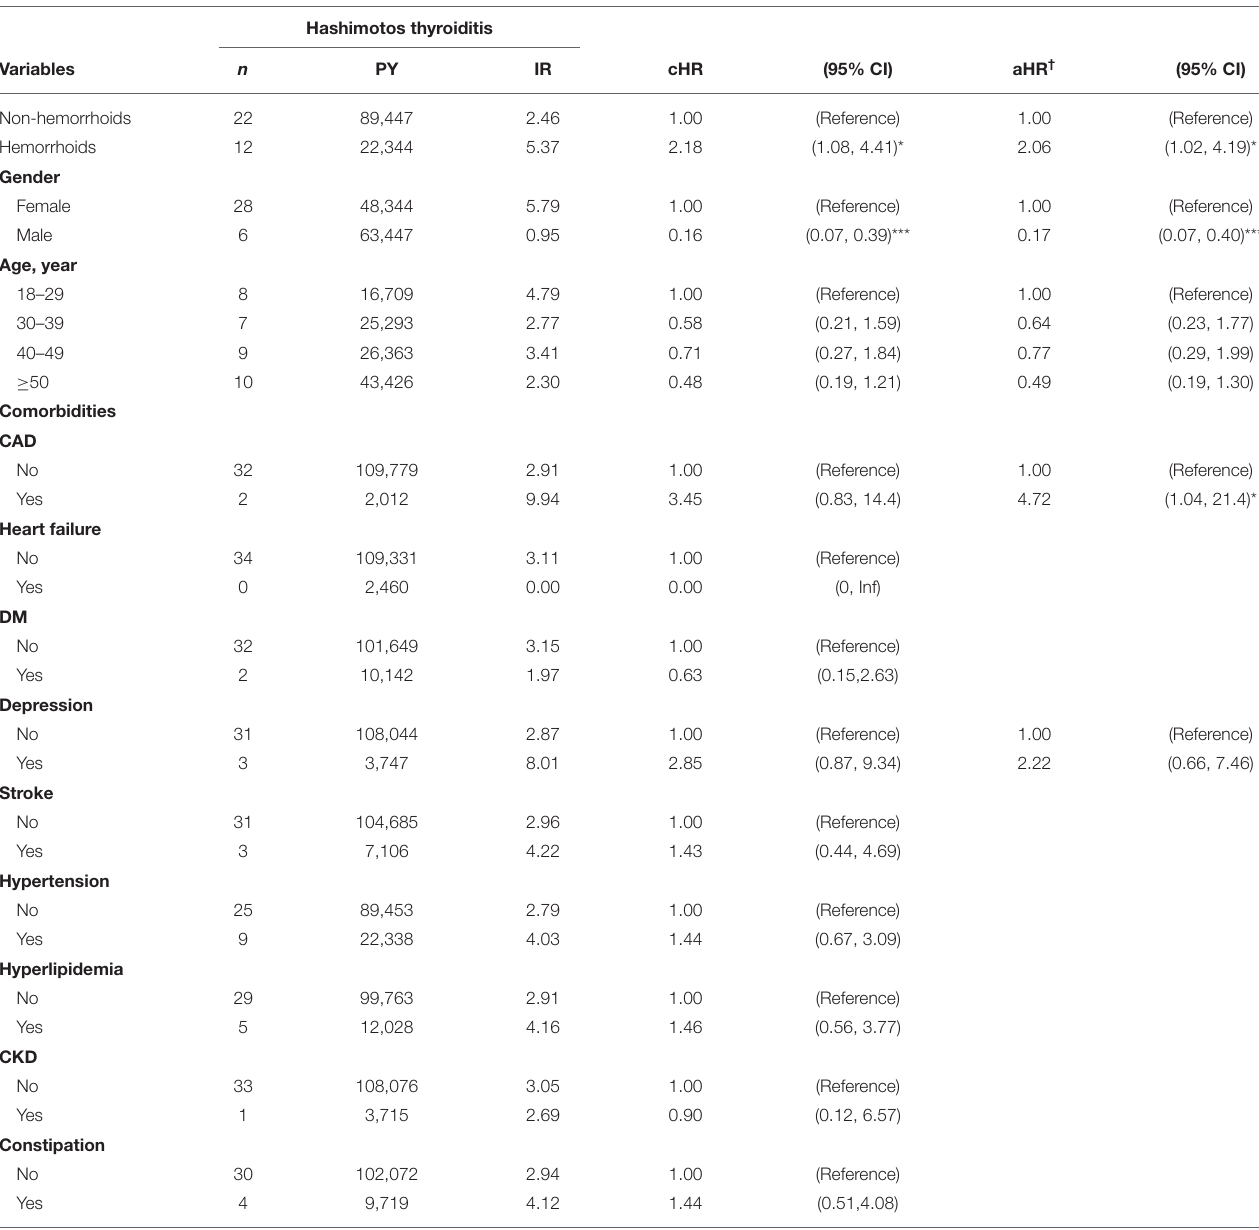
TABLE 2 | Incidence rates and hazard ratios of Hashimoto’s